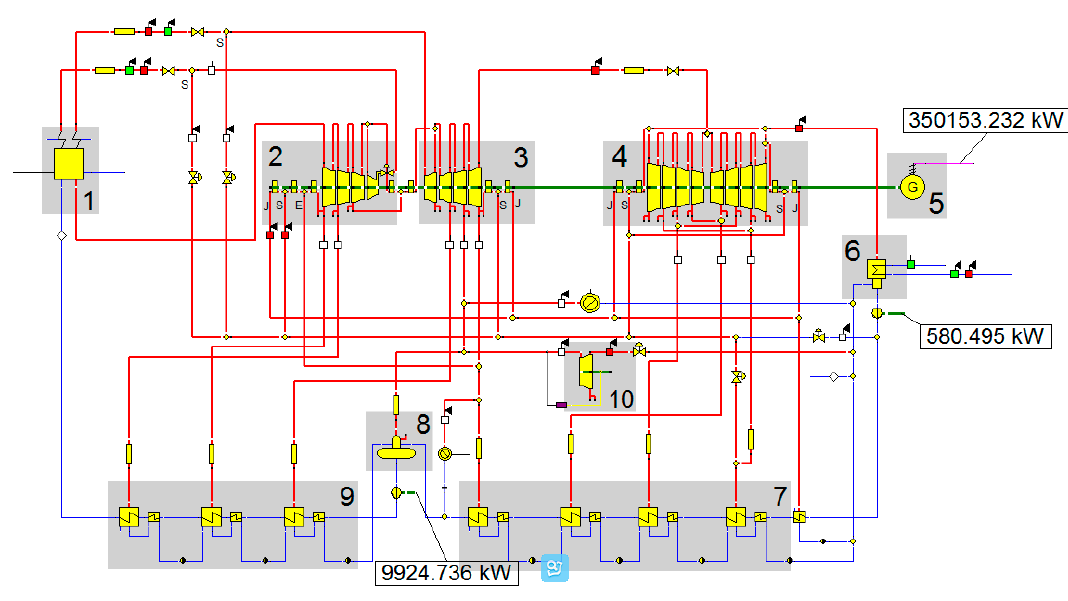
Figure 2. Model of the steam turbine power generating unit.